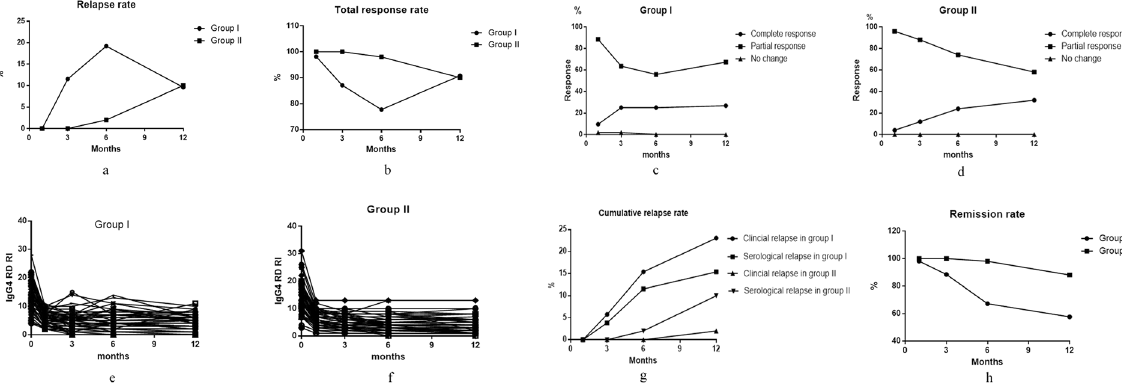
Figure 2. ( A ) Reslapse rate of 2 groups at different time point. ( B ) Total response rate of 2 groups at different time point. ( C ) Complete response, partial response and no change of the IgG4-RD patients in group I. ( D ): Complete response, partial response and no change of the IgG4-RD patients in group II. ( E ) Analysis of IgG4-RD RI before and after treatment in Group I. ( F ) Analysis of IgG4-RD RI before and after treatment in Group II.( G ). The cumulative relapse rate of Group I and Group II. ( H ) Remission rate of 2 groups at different time. Figure 2: IgG4-RD patients, including Group I (with corticosteroid monotherapy) and Group II (with